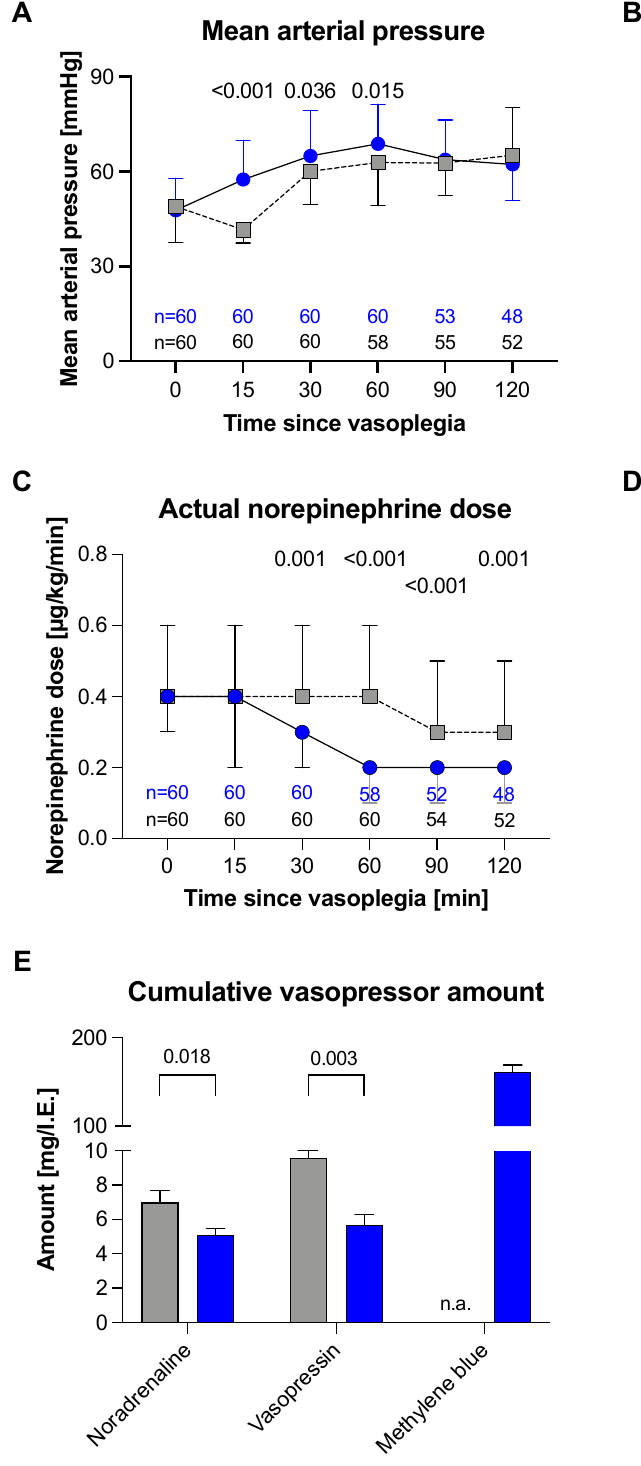
Figure 2. Effects after methylene blue administration in vasoplegic syndrome: The figures show the median (25th–75th percentile) value in the main study group with regard to the use of methylene blue (blue) versus standard therapy (grey). p -value indicates standard mean (SD). ( A ) Mean Arterial pressure; ( B ) Cumulative fluid administration; ( C ) Actual norepinephrine dose; ( D ) Actual vasopressin dose; ( E ) Cumulative vasopressoe amount.